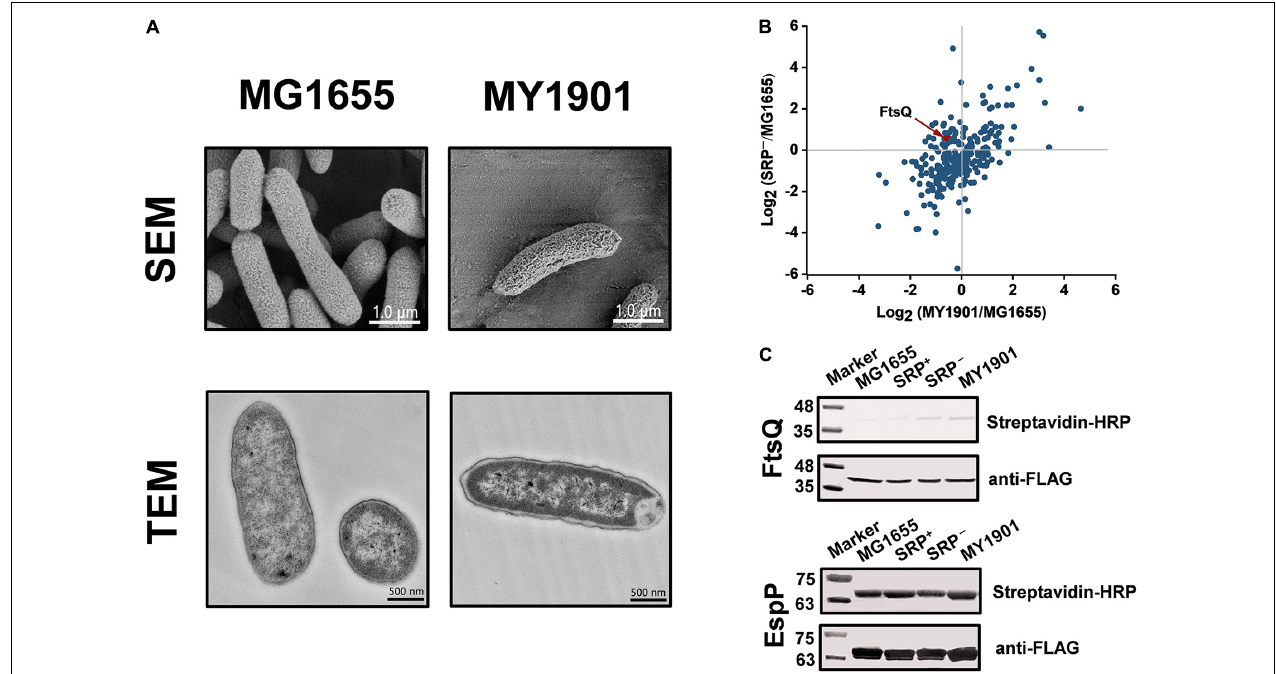
FIGURE 4 | Suppressor mutation suppresses targeting defects of partial inner membrane proteins. (A) Scanning electron microscopy (SEM) and transmission electron microscopy (TEM) analysis of the wild-type strain MG1655 and the suppressor strain MY1901. For SEM, the scale bar is 1.0 µ m. For TEM, the scale bar is 500 nM. (B) Quantification of identified SRP-dependent inner membrane proteins in strains MY1901 and SRP - ( Supplementary Data Set 1D ). Protein abundance of MY1901 and SRP – is relative to that of wild-type MG1655. (C) FtsQ (left) and EspP (right) targeting assay by their biotinylation. SRP + , Ffh expression in HDB51 strain; SRP – , Ffh depletion in HDB51